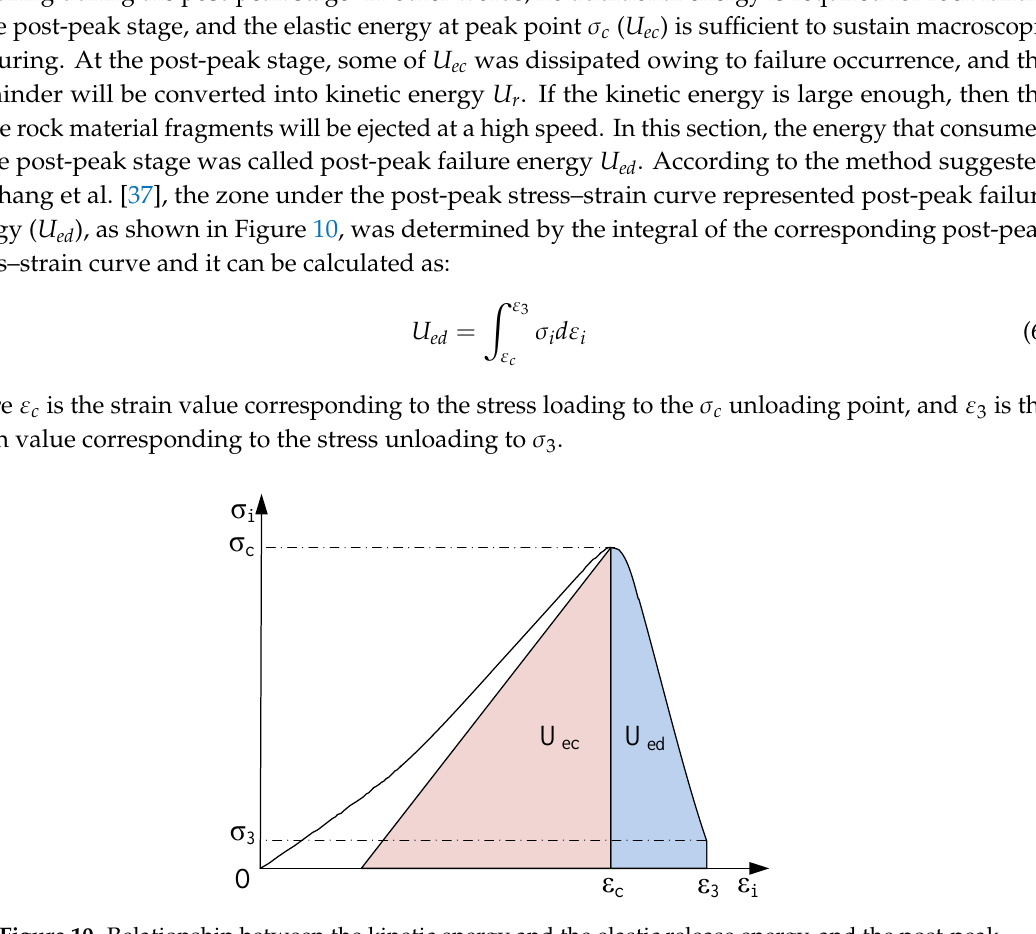
Figure 10. Relationship between the kinetic energy and the elastic release energy, and the post-peak failure energy of CRC specimens during cyclic loading and unloading.